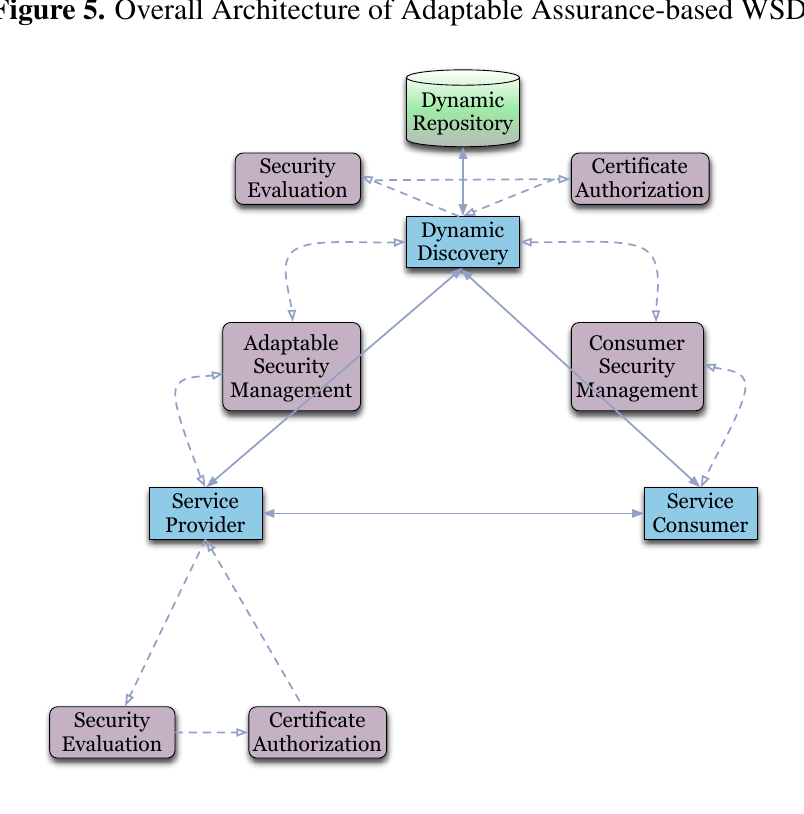
Figure 5. Overall Architecture of Adaptable Assurance-based